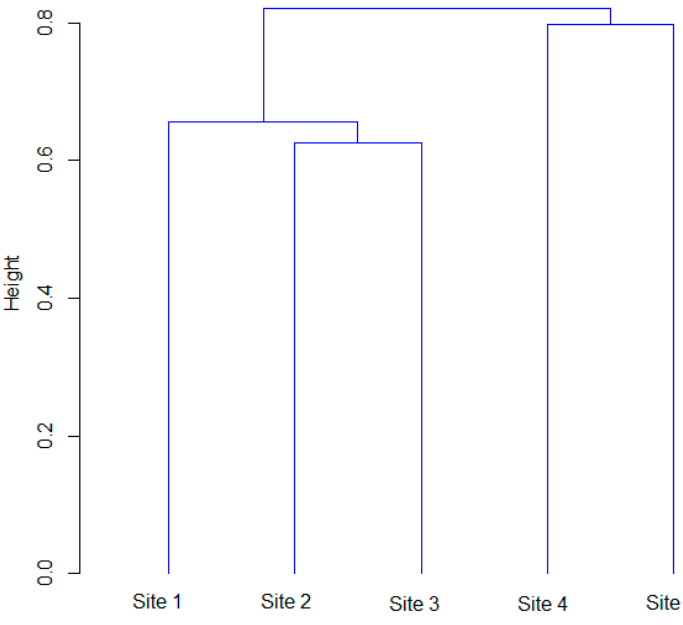
Figure 5. Classification of forests based on ecological distance.